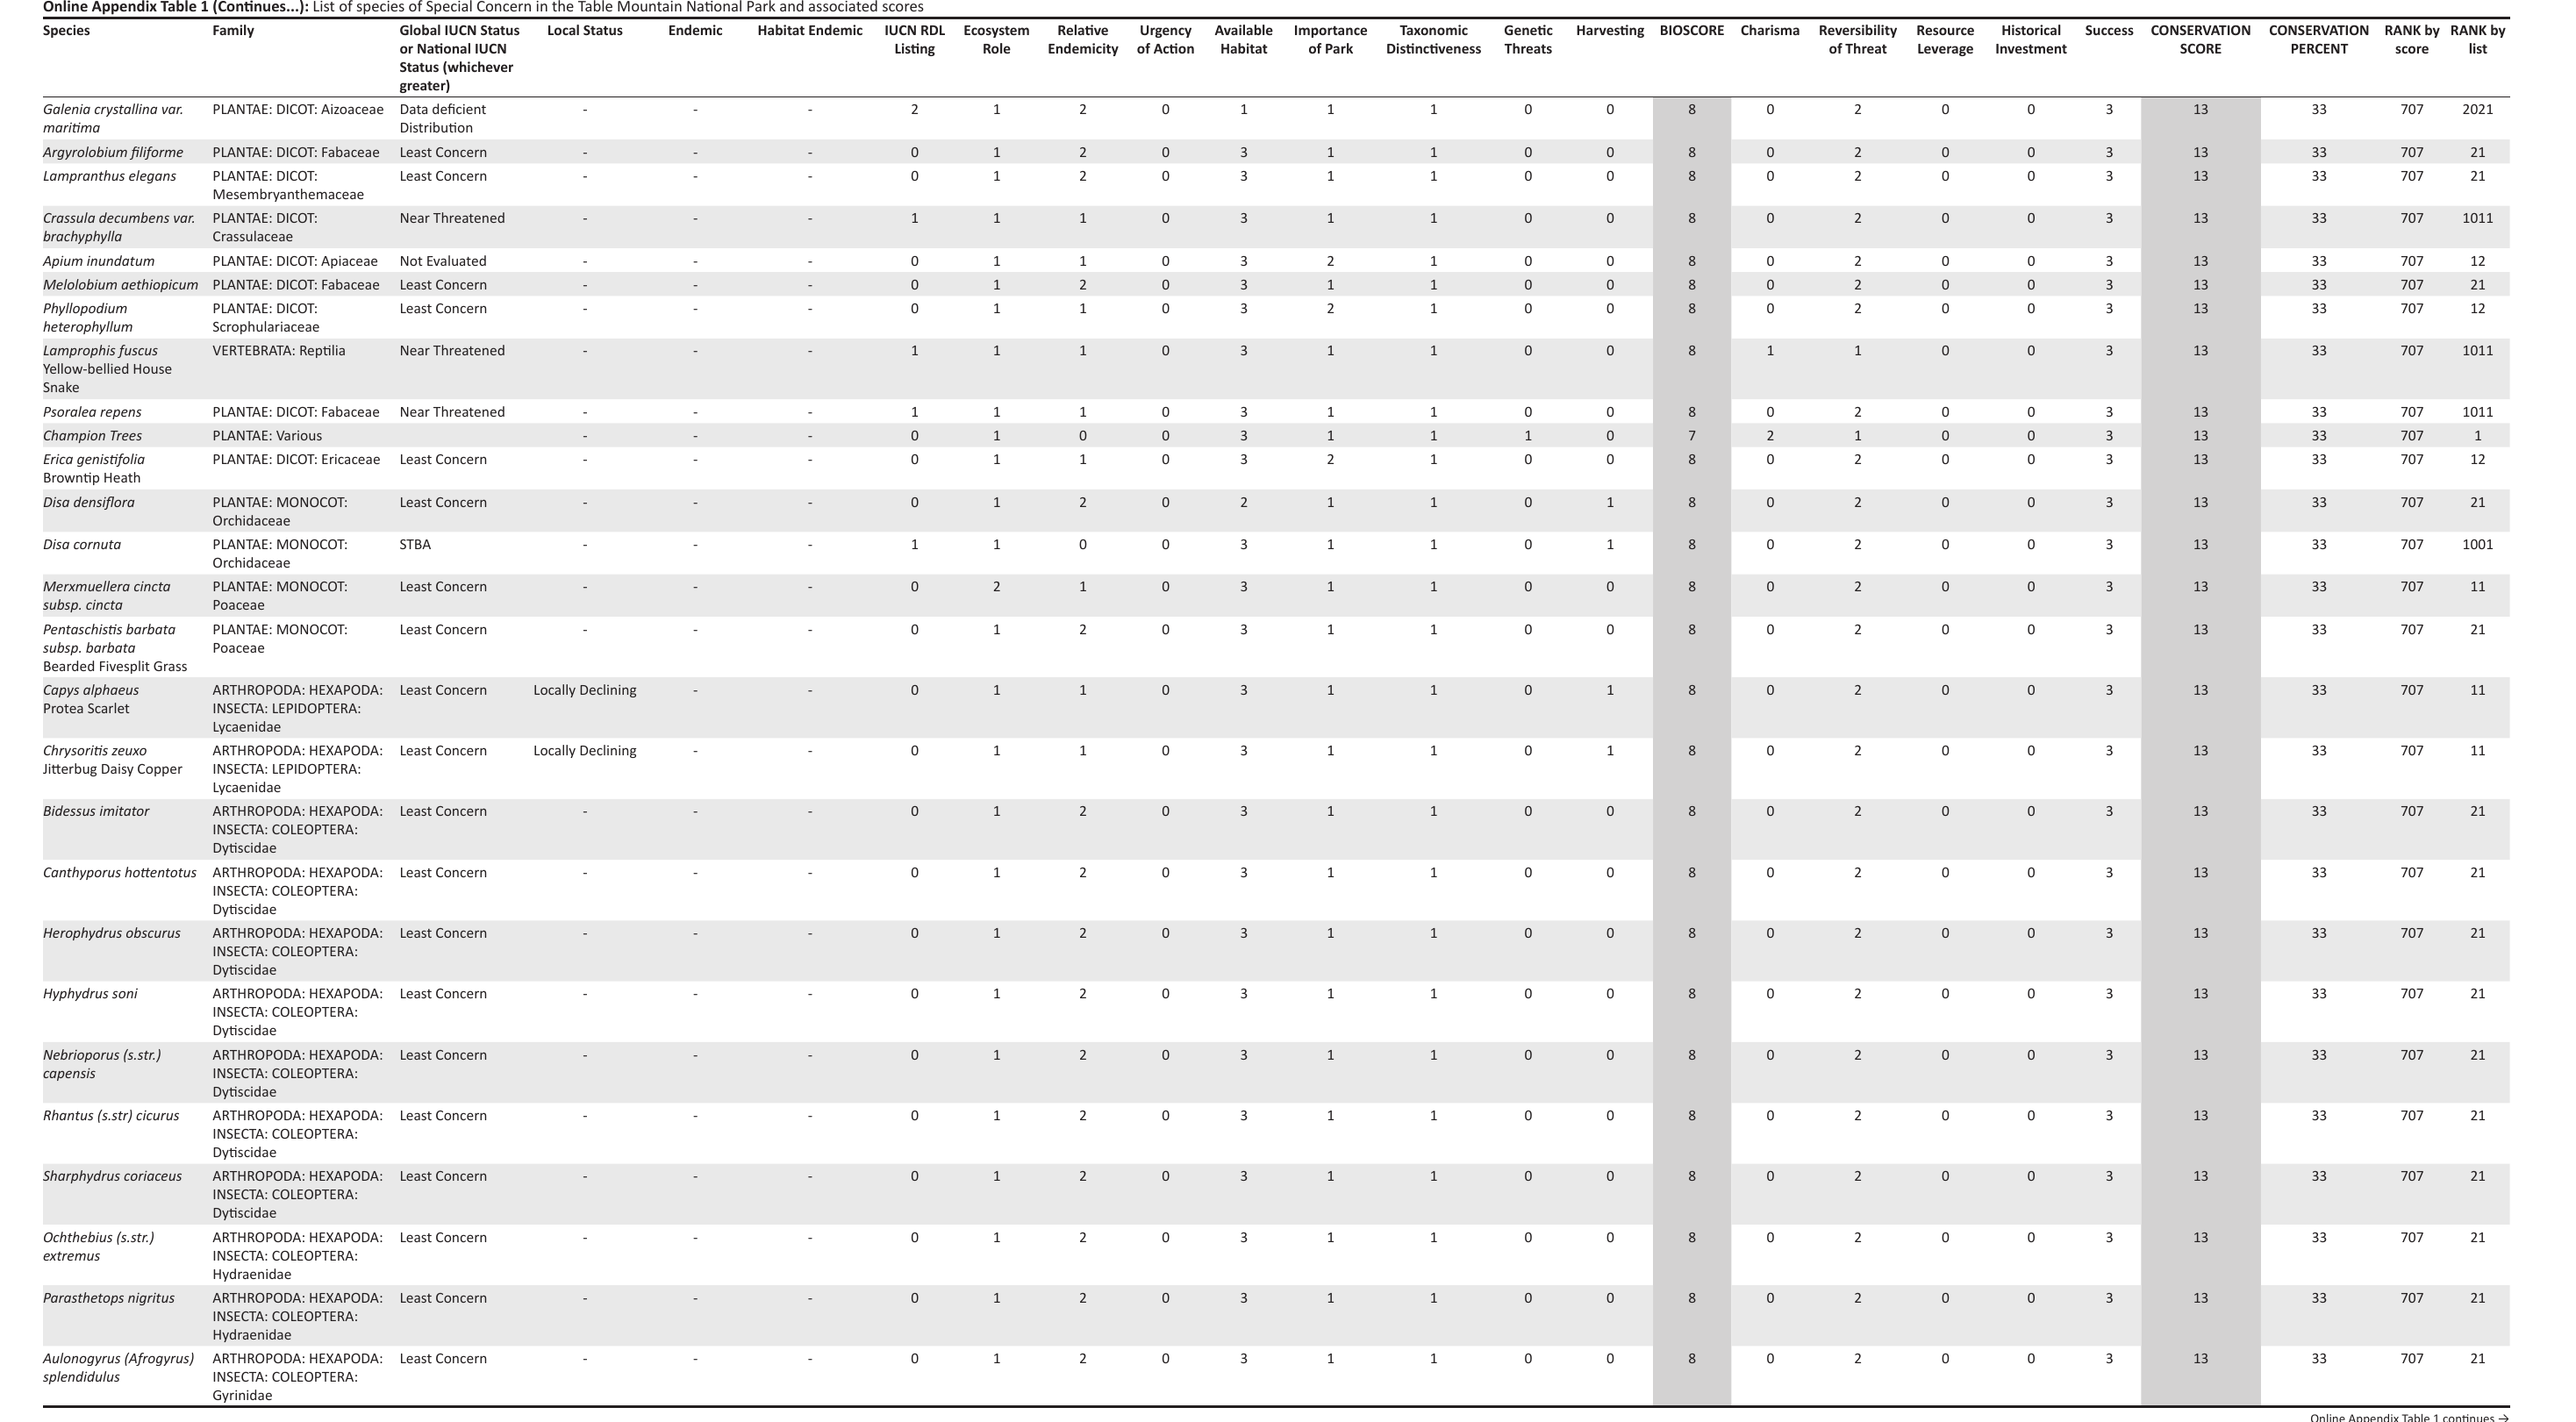
Online Appendix Table 1 (Continues...): List of species of Special Concern in the Table Mountain National Park and associated